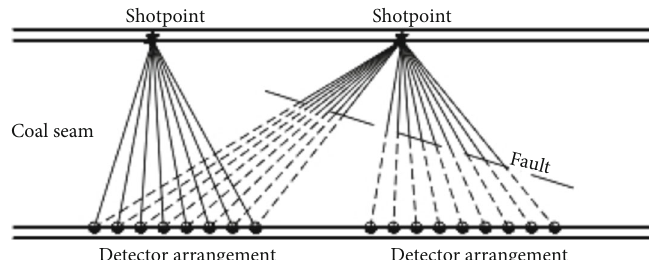
Figure 2: Principle of the transmission Table 1: Description of areas with abnormalities. Serial no.